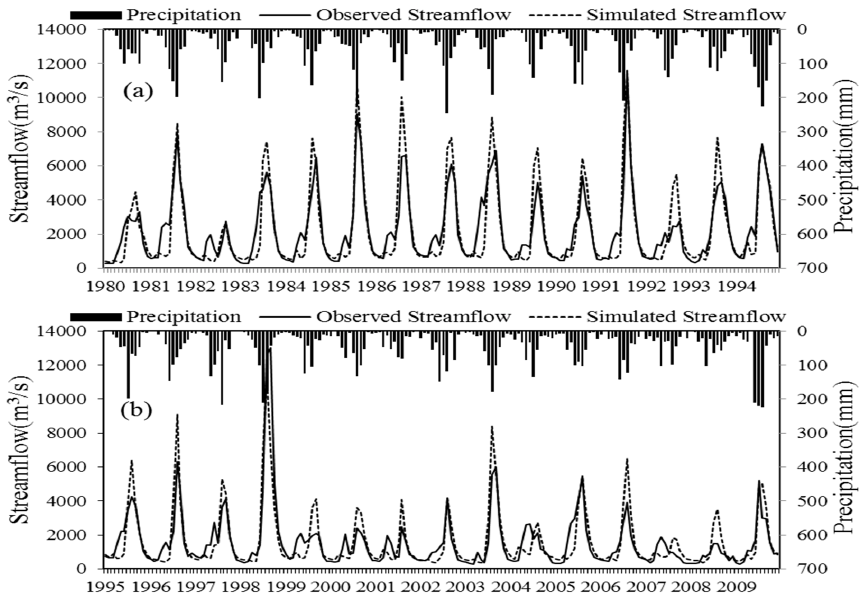
Figure 2. Observed and simulated daily streamflow hydrographs during calibration ( a ) and validation ( b ) periods. Table 4. Evaluation for simulation results of monthly streamflow during calibration and validation